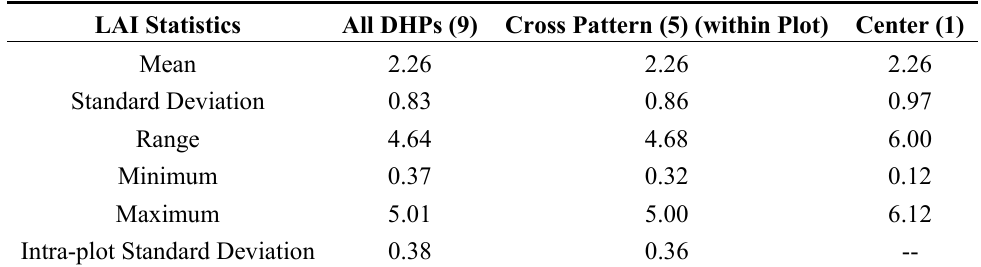
Table 4. Descriptive statistics of three trials using different combinations of DHPs to estimate